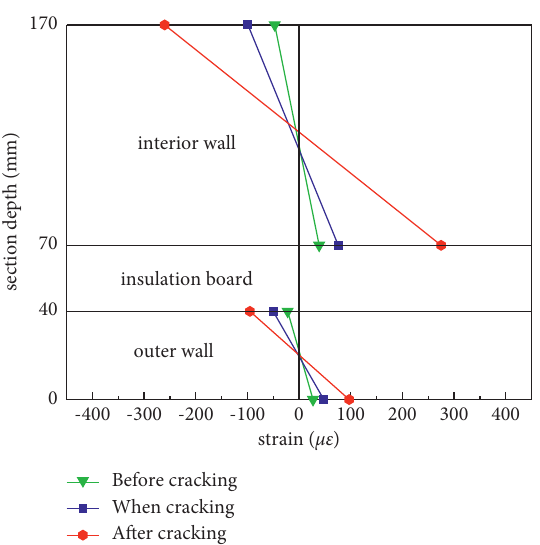
Figure 8: Curve of concrete load-strain